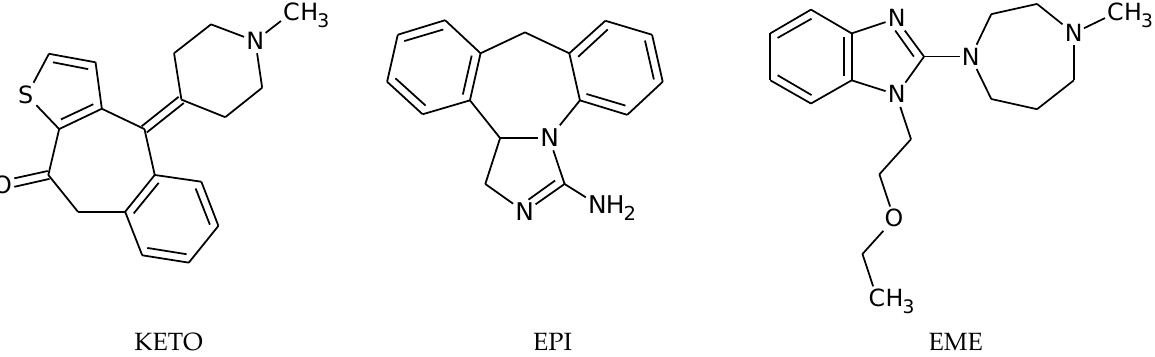
Figure 1. Chemical structures of ketotifen (KETO ) , epinastine (EPI) and emedastine (EME).